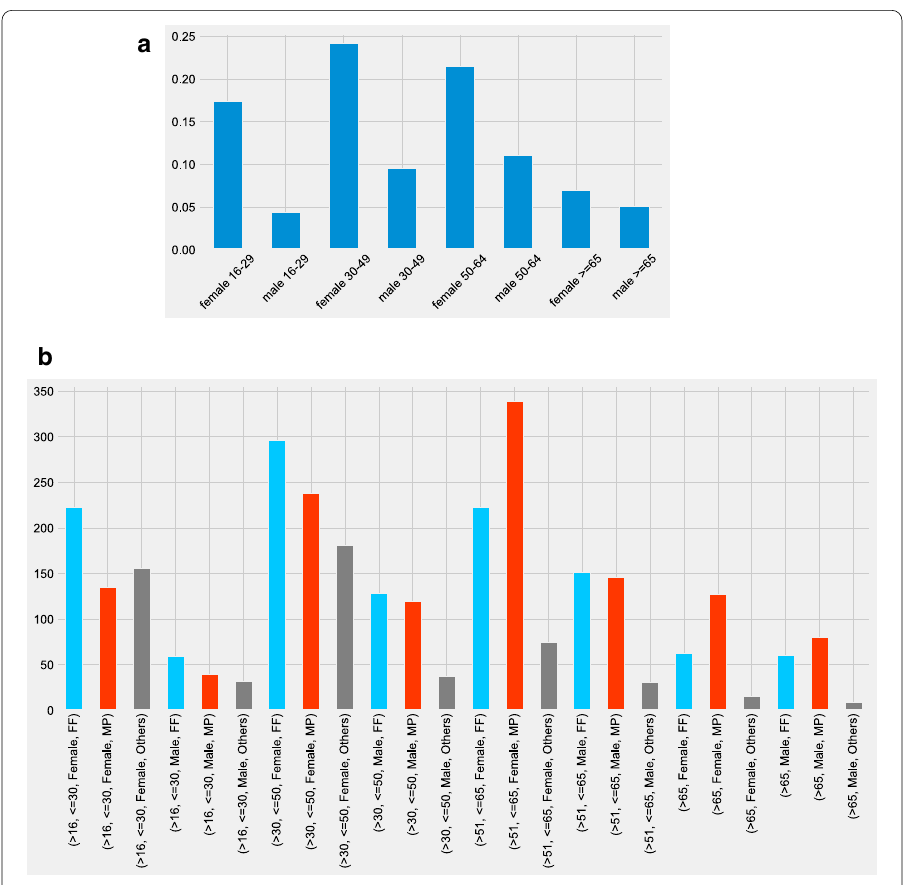
Fig. 3 a Elypsis demographics distribution of respondents to survey conducted after PASO by age and gender. b Elypsis polling results after PASO separated by age and gender (Macri Others =